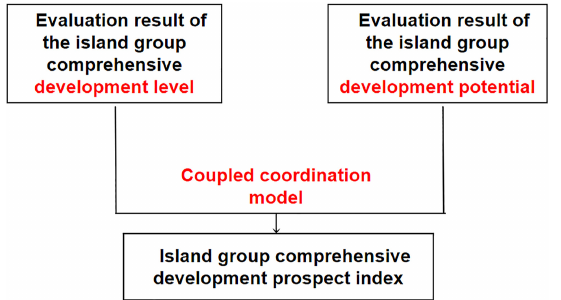
Figure 3. Evaluation process of the prospective index of island-group comprehensive